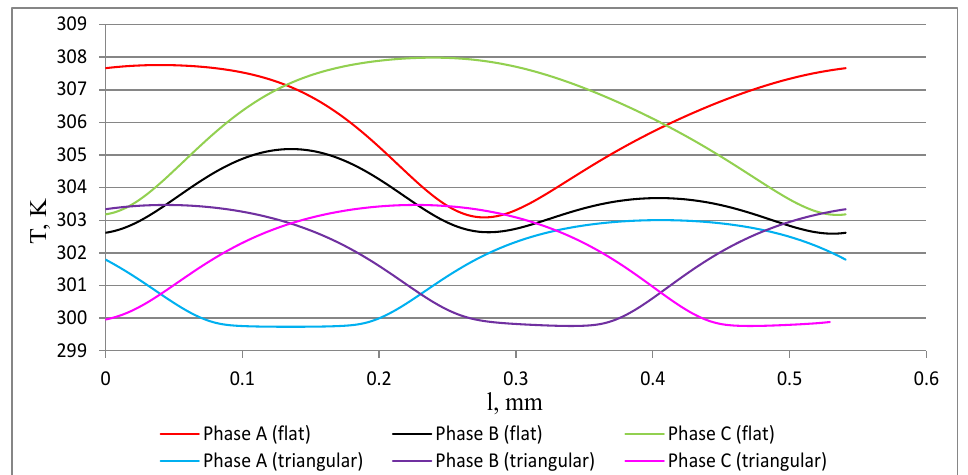
Figure 8. Temperature distribution on the cable surface for the minimum temperature difference in the flat and triangular